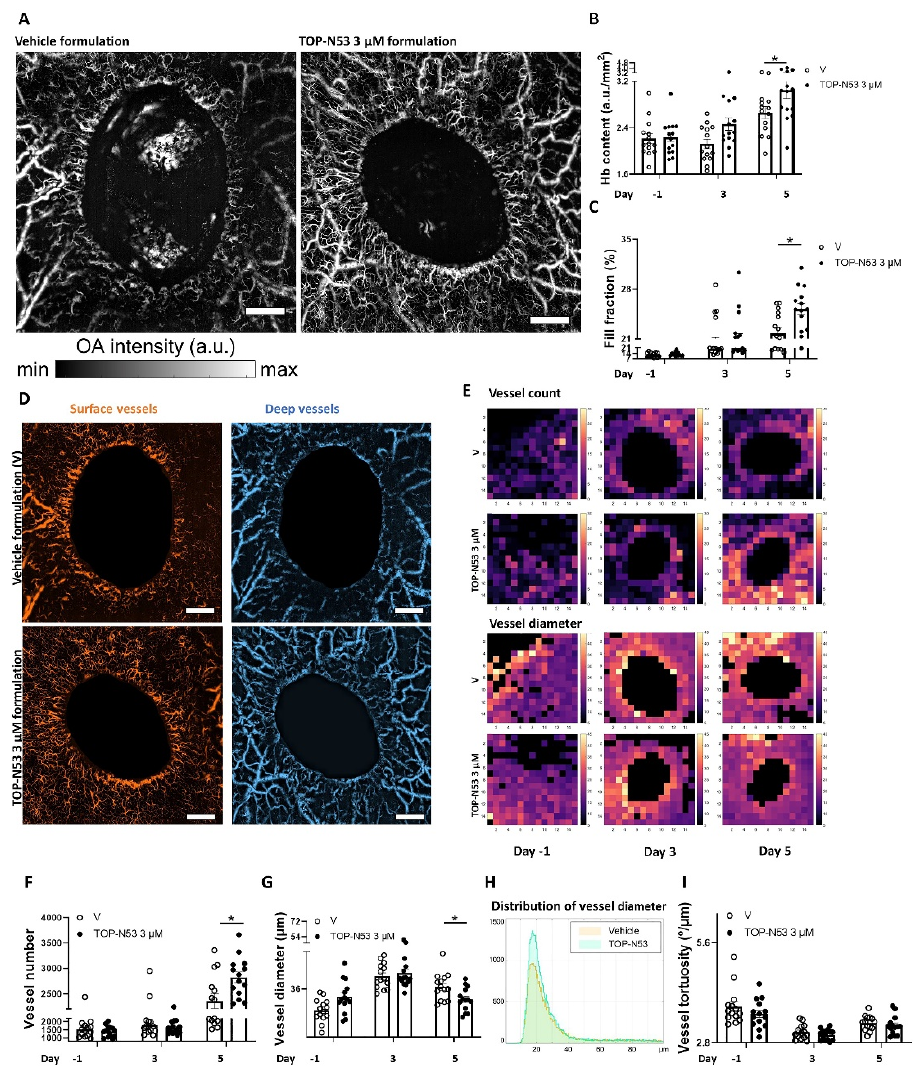
Figure 5. TOP-N53 liquid hydrogel formulation promotes wound blood flow and increases the number of small wound vessels in SKH-1 mice. ( A ) Representative LSOM images of 5-day wounds from SKH-1 mice treated topically either with vehicle hydrogel formulation (V) or TOP-N53 3 µM liquid hydrogel formulation. Magnification bars: 1 mm. The colormap represents optoacoustic signal intensity in arbitrary units (a.u.). ( B , C ) Analysis of hemoglobin (Hb) content (a.u./mm 2 ) ( B ) or percentage of fill fraction ( C ) based on LSOM images acquired pre- and post-wounding at different time points. n = 14 wounds per treatment group. V: vehicle. ( D ) Representative LSOM images of wound vessels segmented into superficial (orange) and deeper (blue) vessels based on their size and relative depth to the skin surface. Magnification bars: 1 mm. ( E ) Spatial-averaged heatmaps (each pixel corresponds to 0.46 × 0.46 mm 2 area) showing a qualitative assessment of vessel number and diameter per pixel pre- and post-wounding at different time points. n = 14 wounds. Analysis of vascular parameters including number of vessels ( F ), vessel diameter ( G ), distribution of vessel diameter ( H ) and vessel tortuosity ( I ). All parameters were calculated based on LSOM images acquired pre- and post-wounding at different time points. n = 14 wounds. All bars represent mean +/ − SEM. Statistics is shown for day 5. * p ≤ 0.05 (Two-way ANOVA and Bonferroni multiple comparisons